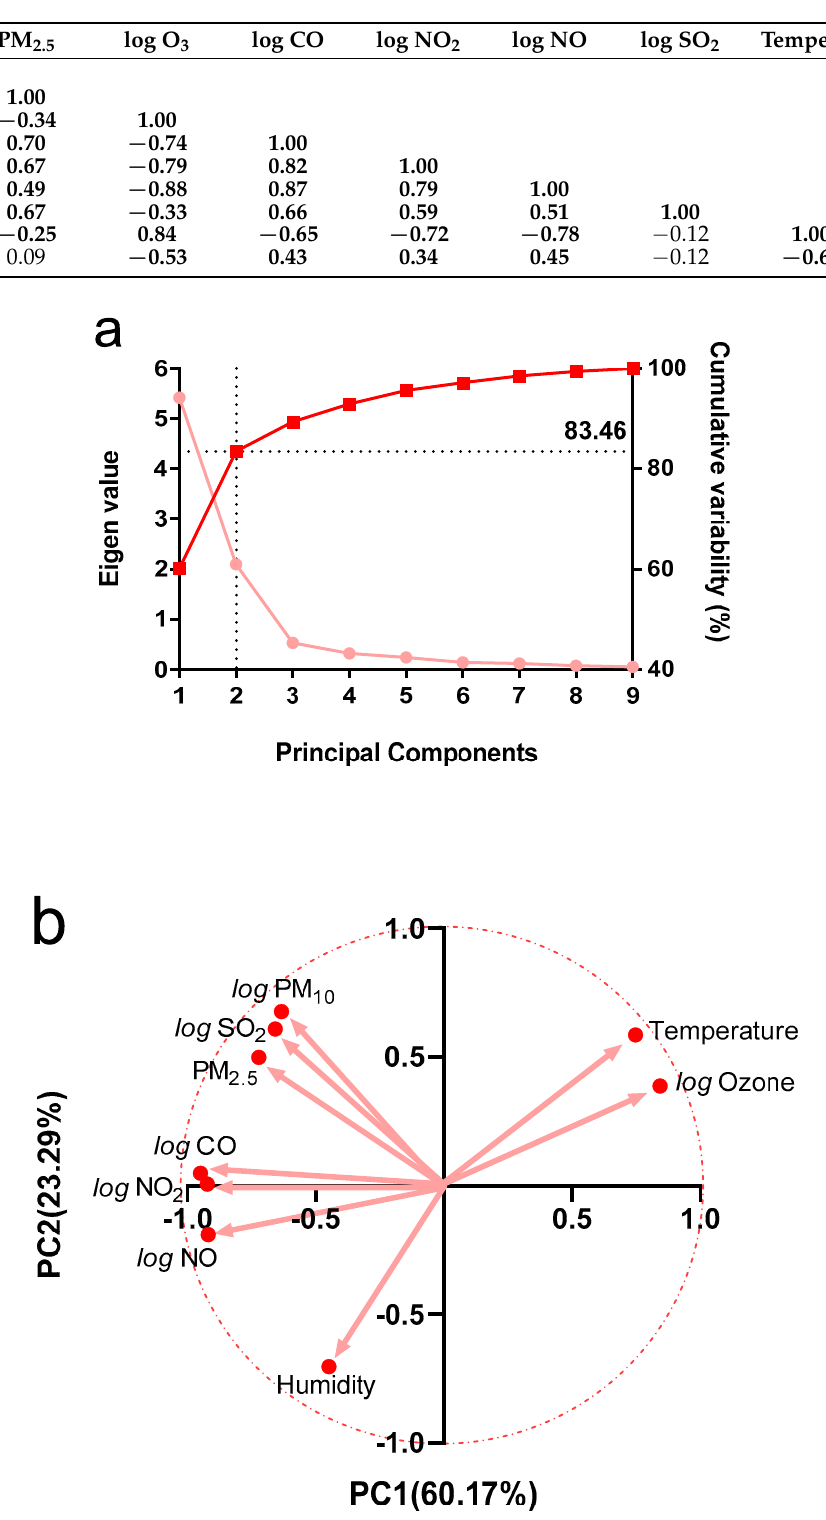
Figure 3. Eigenvalues and cumulative variability versus principal components ( a ). Biplot of PC1 versus PC2 ( b ). The arrow size represents the contribution of each variable, while location represents the sign of the association with each component.